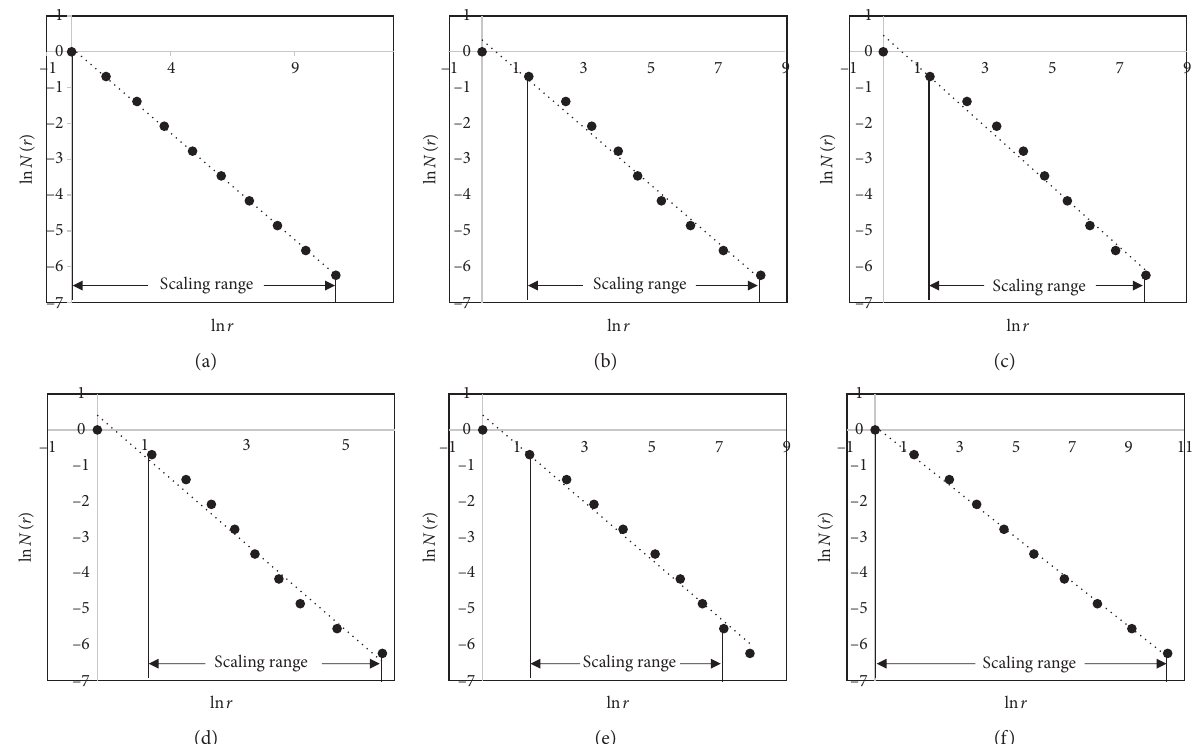
Figure 3: Bilogarithmic plots of various types of green space estimated by using grid dimensions: (a) G , (b) G 1, (c) G 2, (d) G 3, (e) G 4, and (f) G 5.